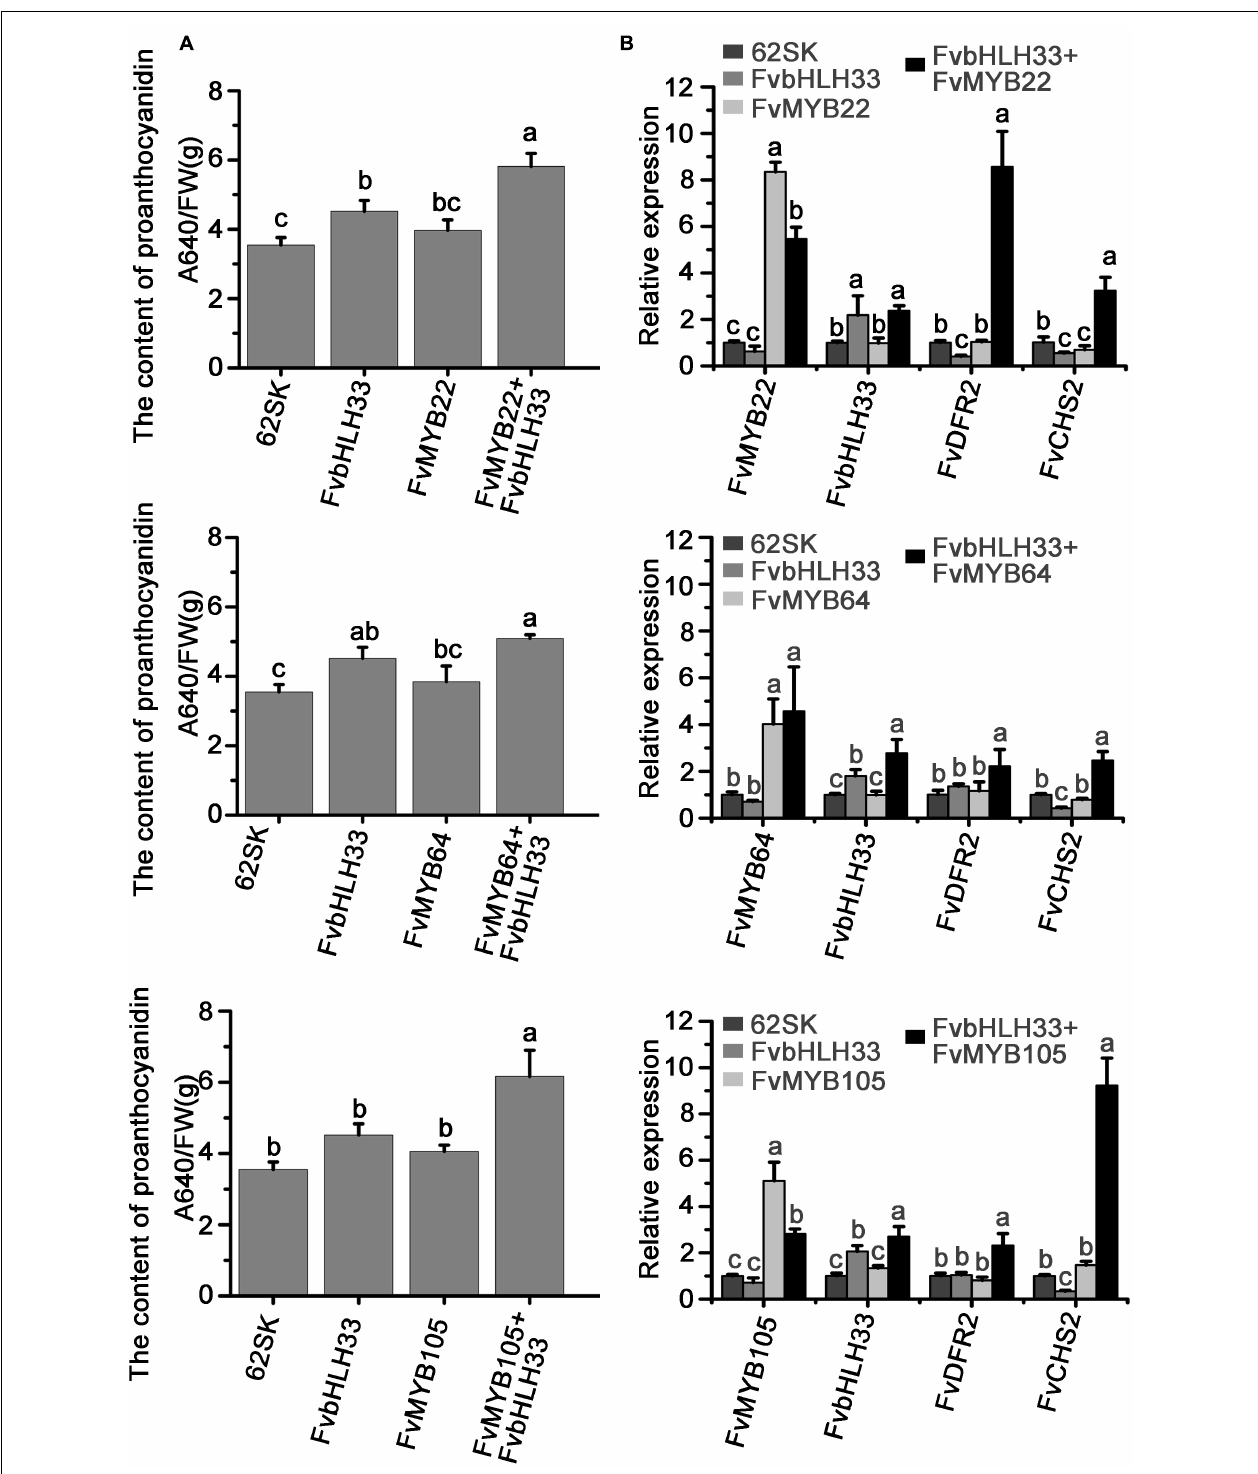
FIGURE 9 | The complex of FvMYB and FvbHLH33 can promote the accumulation of proanthocyanidin in strawberry fruits. The Agrobacterium containing the indicated combinations of constructs were injected into strawberry fruits and the content of proanthocyanidins was detected at 7 days after injection. (A) Measurement of proanthocyanidin related to the transient expression of FvMYB and FvbHLH proteins. (B) Relative expression levels of FvMYBs, FvbHLH33 , FvCHS2, and FvDFR2 genes from transient expression. Fv26S served as an internal control. Data are presented as the mean ± SD ( n = 3). The letters a–c indicate statistically significant differences, as determined by Tukey’s LSD test ( P ≤